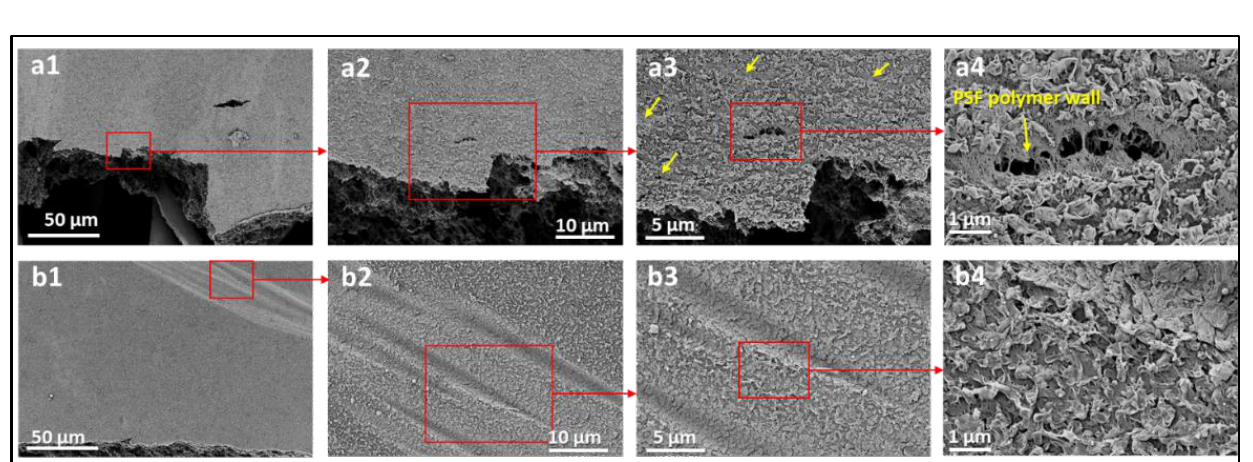
Figure 9. SEM images of BW30-0° membrane tested under ( a1 – a4 ) dry condition and ( b1 – b4 ) wet condition. The small yellow arrows indicate the regions of PA layer delamination in dry conditions.